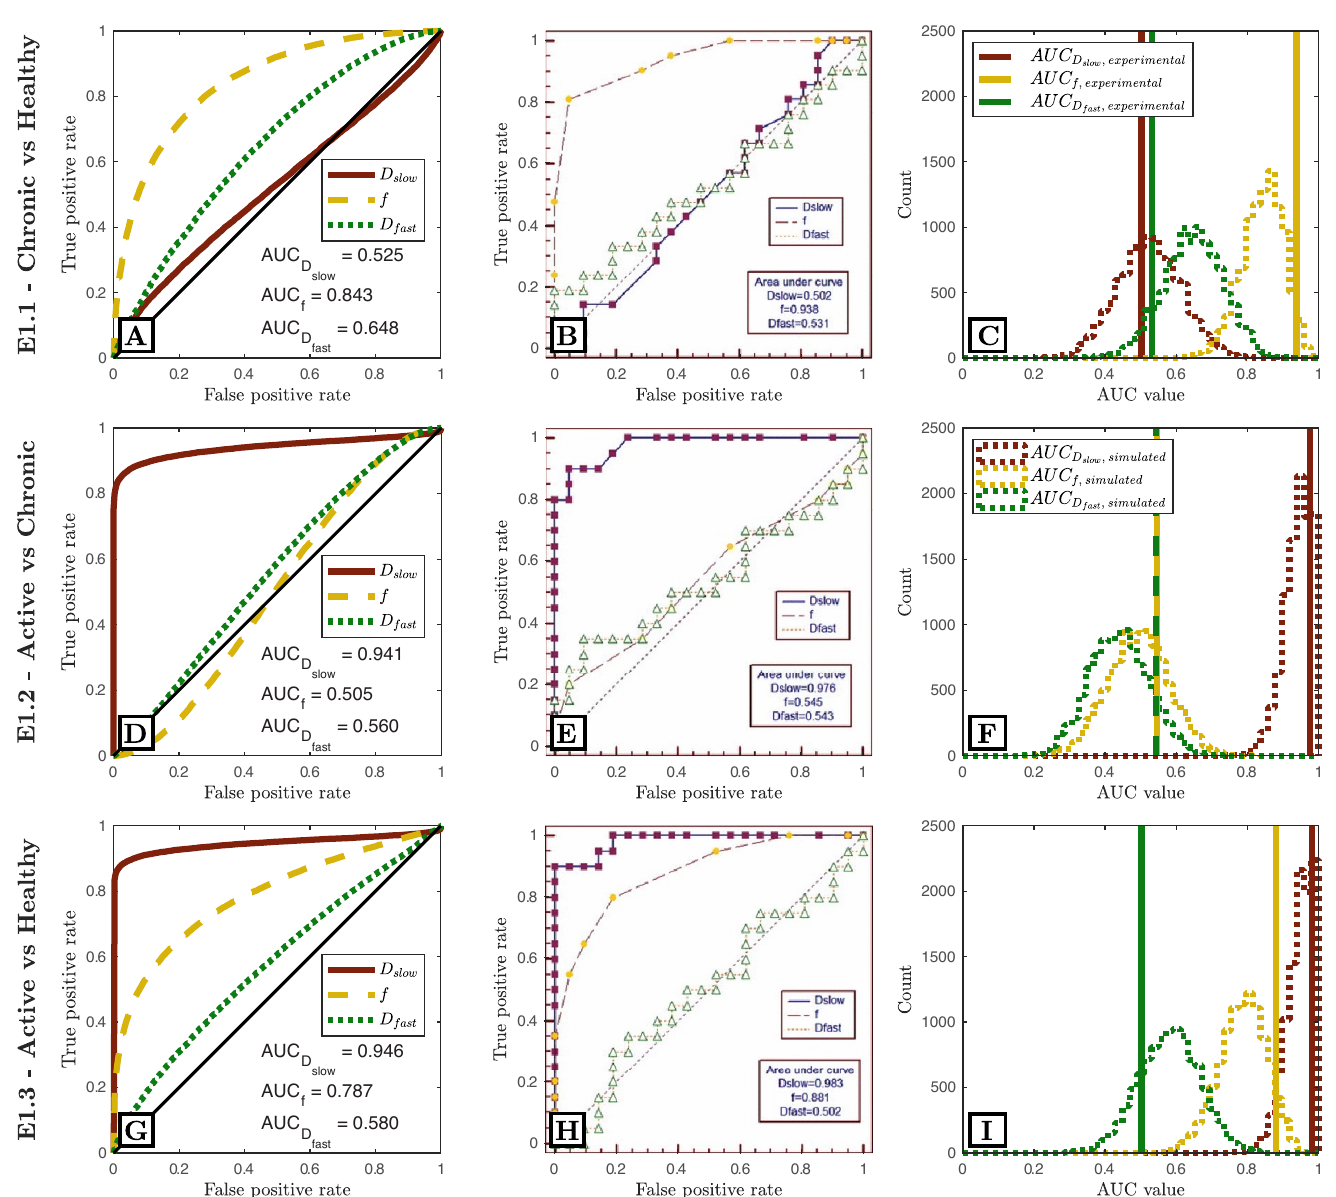
Fig 2. Simulated (first column) vs. clinical (middle column) ROC curves for Zhao’s dataset (E1.1-E1.3). The third column compares clinical AUC values (vertical lines) to simulated AUC values (distributions) when sub-sampling simulated data to match clinical study sizes. All ROC curves are qualitatively similar; the relative performances (AUC values) of different IVIM parameters are equal; all AUC values are in numerical agreement once clinical sample size is